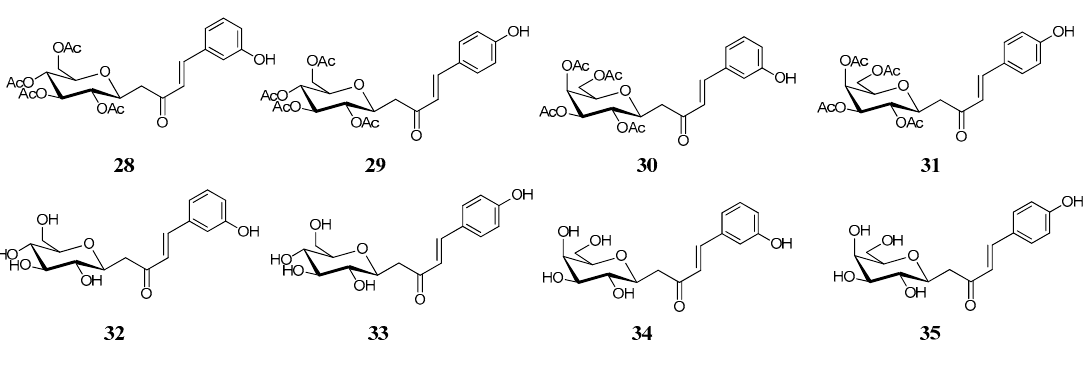
Figure 8. Structures of the cinnamoyl glycosides 28 – 35 [52]. Table 3. Inhibition of mammalian α -CA with the C -cinnamoyl glycosides 28 – 35 and phenol 1 . No.